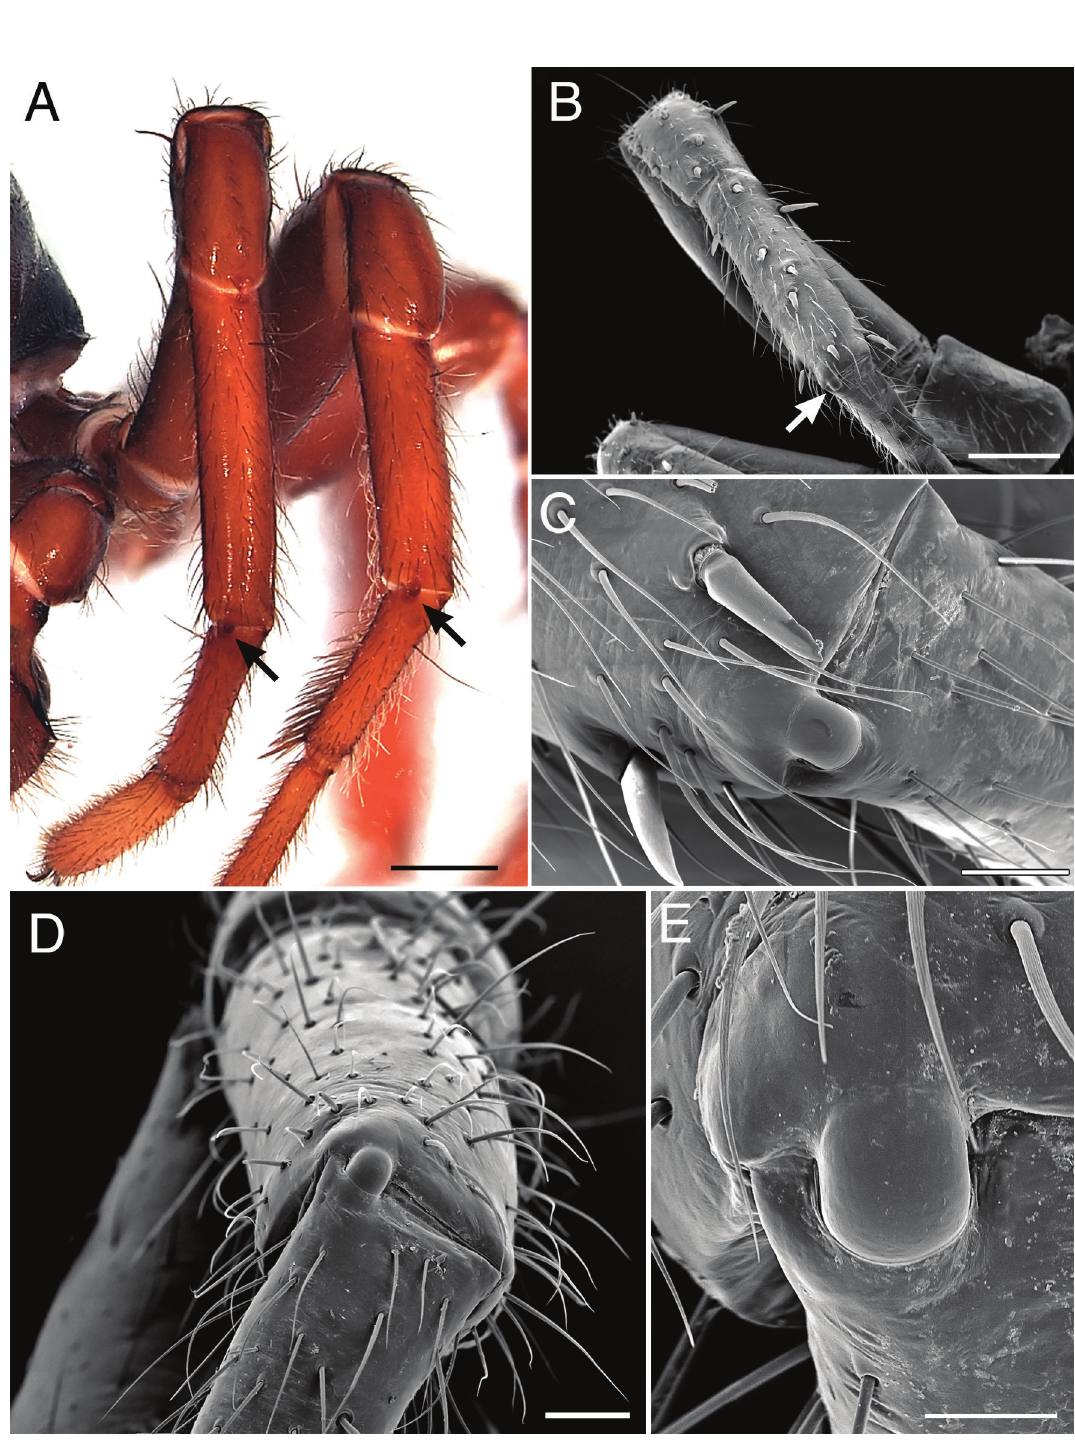
Fig. 17. Palindroma morogorom gen. et sp. nov. A . Left legs I and II, frontal view; arrows indicate tibial process. B . Left leg III, tibia and metatarsus, dorsal view. C . detail of previous. D . Left leg II, tibia and metatarsus, dorsal view. E . detail of previous. Scale bars: A–B = 0.5 mm, c–d = 100 mm, e = 50